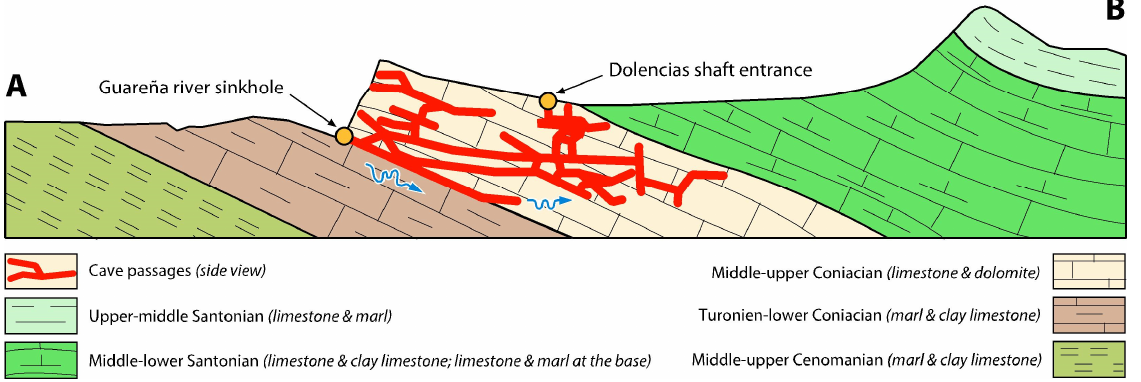
Figure 2. Geological section approximately North-South, corresponding to line A–B in Figure 3.